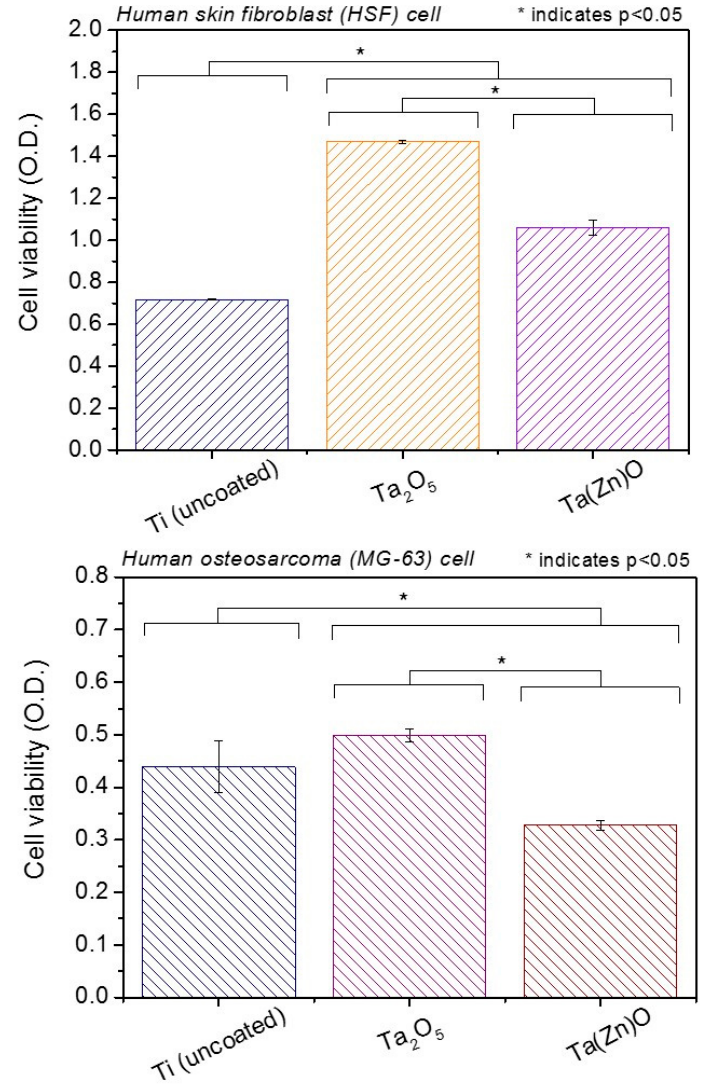
Figure 8. Cell viabilities of fibroblast cells and osteosarcoma cells on each sample. HSF and MG-63 cells were individually and directly cultured onto each kind of specimen for 48 h followed by MTT assay. The mean vales of O.D. were different significantly among all samples ( p < 0.05). Post-hoc pairwise comparisons were conducted by the Turkey test and the differences were considered significant when p < 0.05.